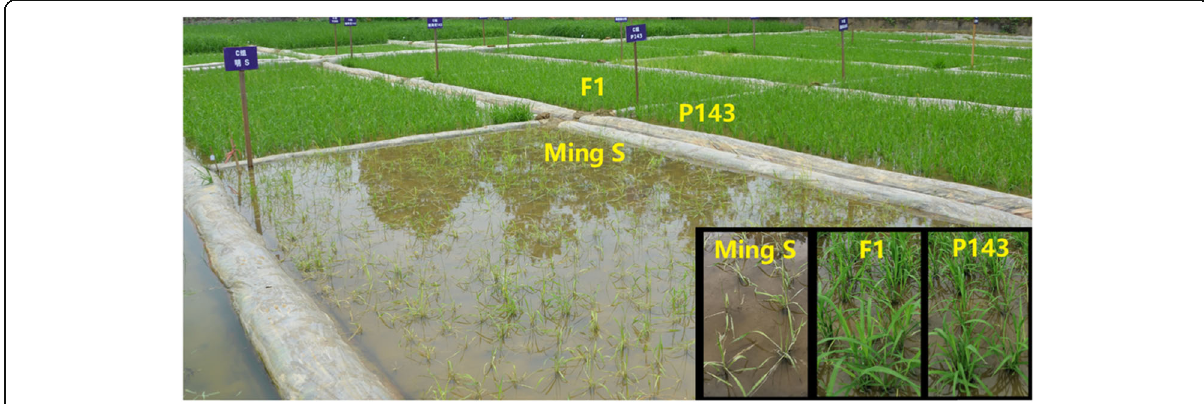
Fig. 5 Field phenotype of Mingliangyou143 and its parents to BBC. The 2-line hybrid rice variety Mingliangyou143 (F1) and its female parent MingS and male parent P143 were grown in a paddy field treated with BBC (300 g of active ingredient/ha) at 10 days after direct seeding. Examination of the plants at 25 days after direct seeding revealed that F1 and P143 were resistant to BBC, whereas MingS was